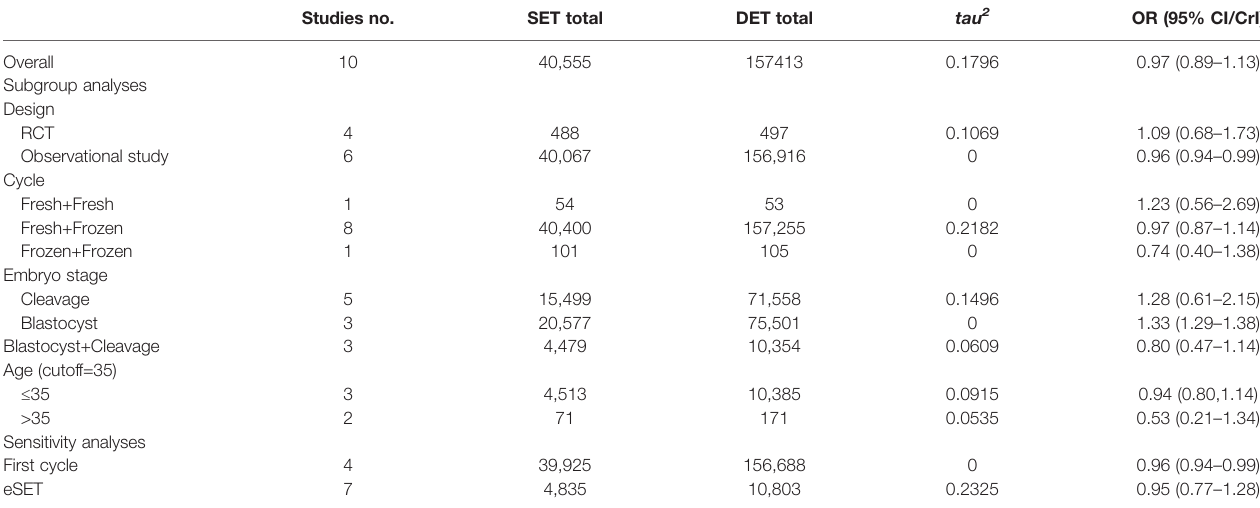
TABLE 1 | Sensitivity and subgroup analyses comparing cumulative live birth rate after two consecutive cycles of SET (2SETs) and one cycle of DET. Studies no. SET